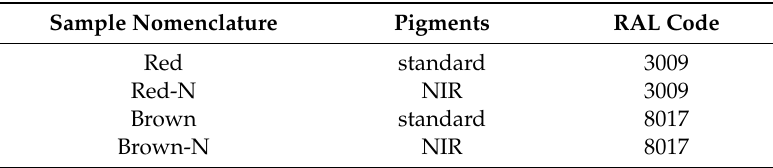
Table 1. Coatings color, with relative nomenclature.